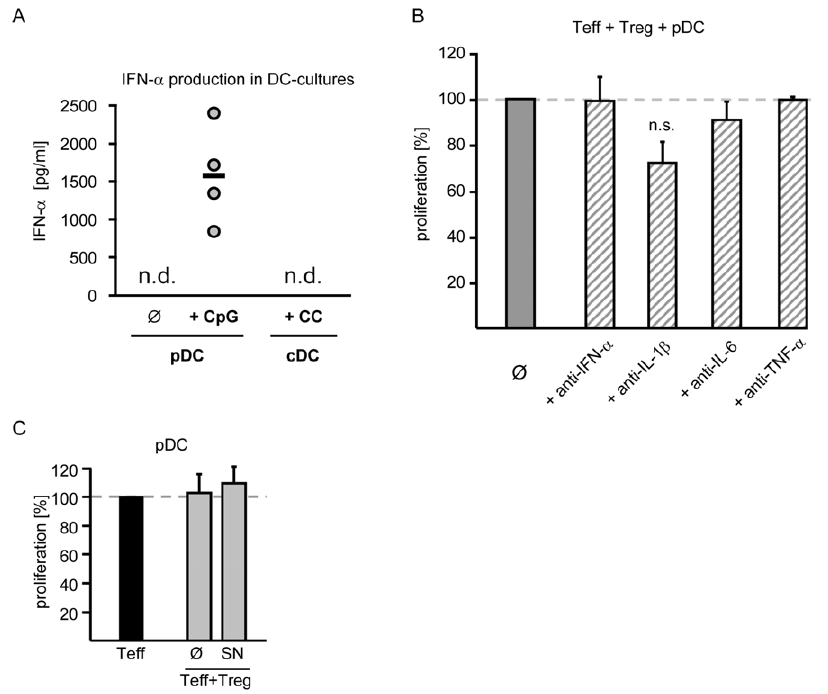
Figure 4. Neutralization of proinflammatory cytokines does not restore Treg suppression. A: Production of IFN- a by activated pDC. Supernatants of activated pDC (CpG/IL-3) or cDC (cytokine cocktail) cultures were harvested. Production of IFN- a was investigated by ELISA. Each circle resembles one individual experiment, bar represents mean; n.d.: not detectable, n=4. B: Neutralization of cytokines in cocultures of Teff, Treg and pDC. Teff plus Treg (1:1) were stimulated with allogeneic pDC at a ratio of 1:5 in absence (Ø) or presence of neutralizing antibodies against IFN- a , IL-1 b , IL-6 or TNF- a (10 m g/ml each). Proliferation in cocultures (mean 6 SD of triplicates) is normalized to untreated cocultures (set to 100%). One representative experiment out of three is shown. C: Addition of supernatants from standard cultures. CD4 + Teff and Treg (1:1) were stimulated with anti-CD3 mAb (0.5 m g/ml) plus irradiated TC-depleted PBMC. Supernatants from these cocultures were collected on day 3 and titrated (1:2) to pDC- stimulated CD4 + Teff, Treg or cocultures. Proliferation was assessed on day 3 by 3 H-Tdr-incorporation. Diagrams show mean values ( 6 SD) of three independent experiments. Proliferation of untreated and treated cocultures was normalized to untreated or treated Teff-proliferation (set to 100%).